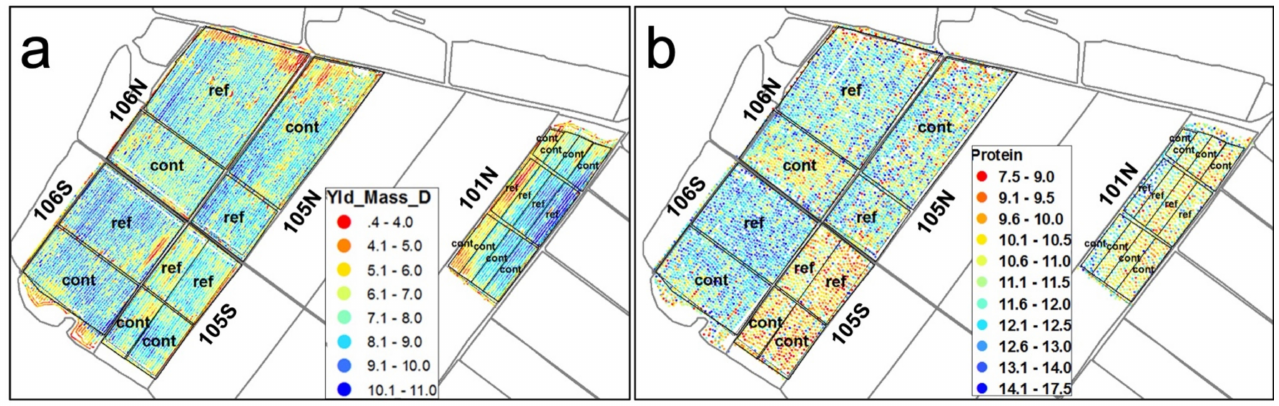
Figure 8. ( a ) Wheat grain yield (t ha − 1 ) and ( b ) grain protein content (%) maps of five fields in Saad (in Figure 7) for the 2019 season.